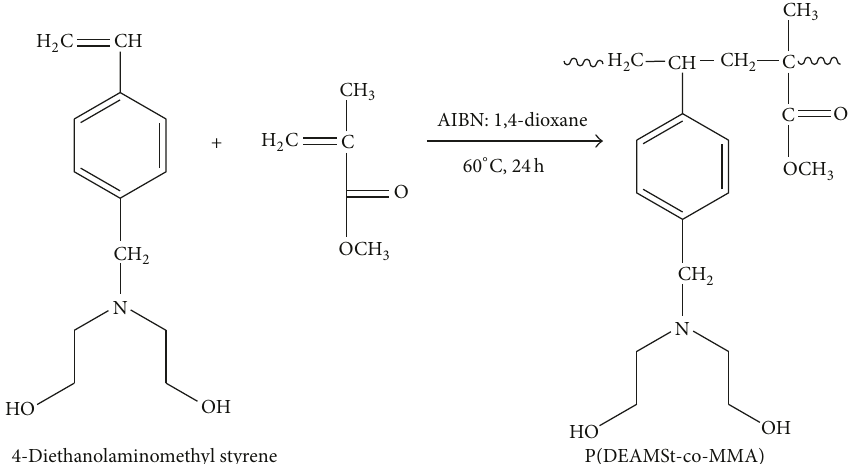
Figure 4: Synthesis reaction of P(DEAMSt-co-MMA).